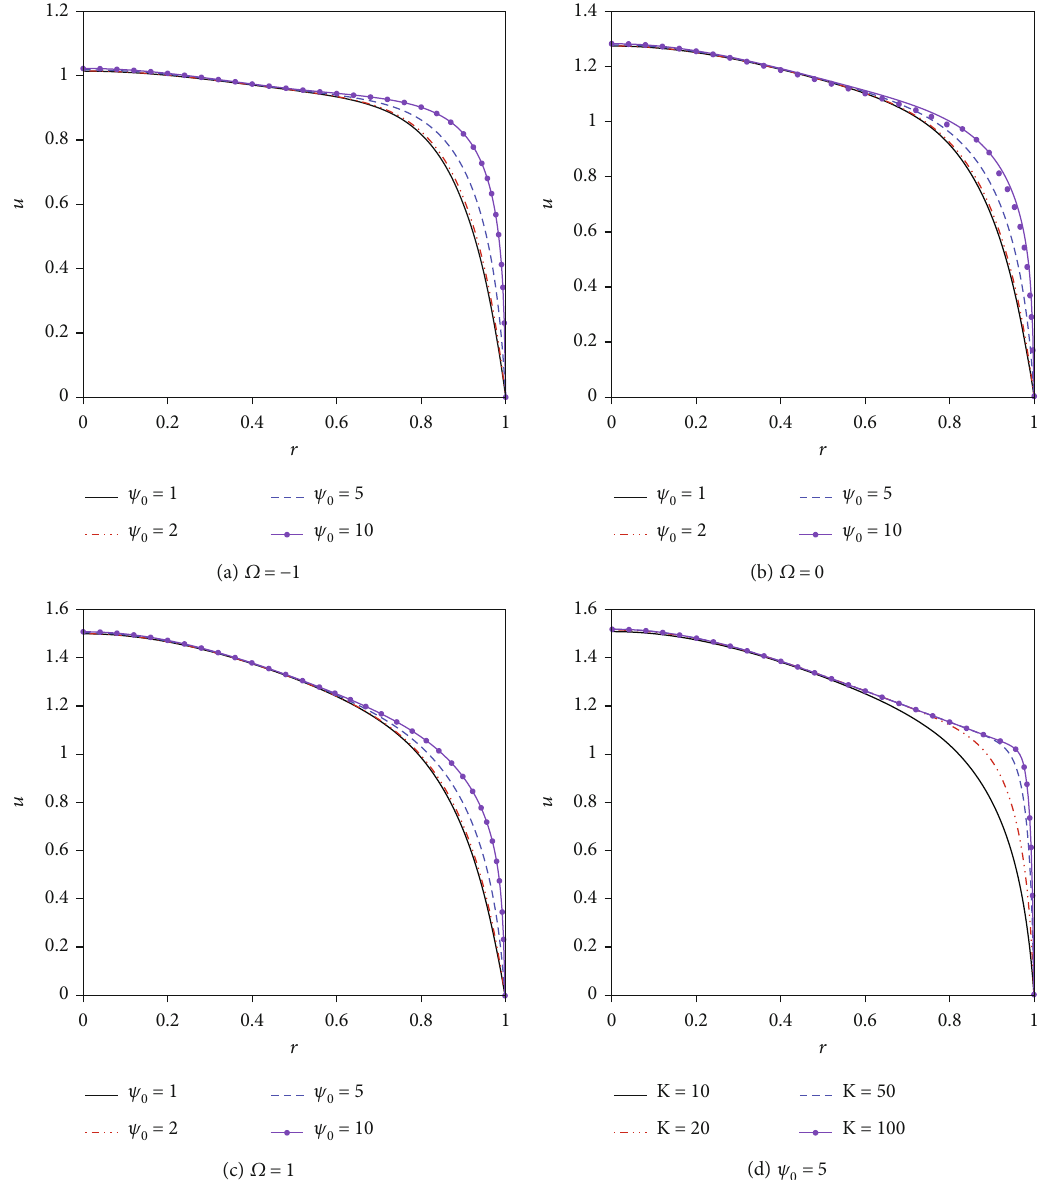
Figure 6: Dimensionless velocity distribution in a circular microchannel ( λ